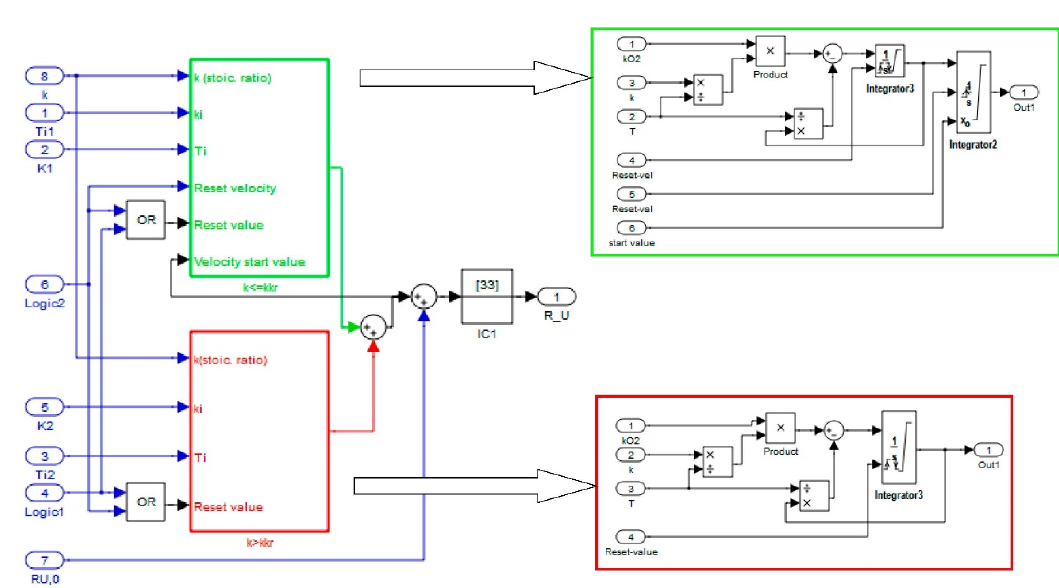
Figure 12. Step for calculation of voltage range in the fuel cell stack.